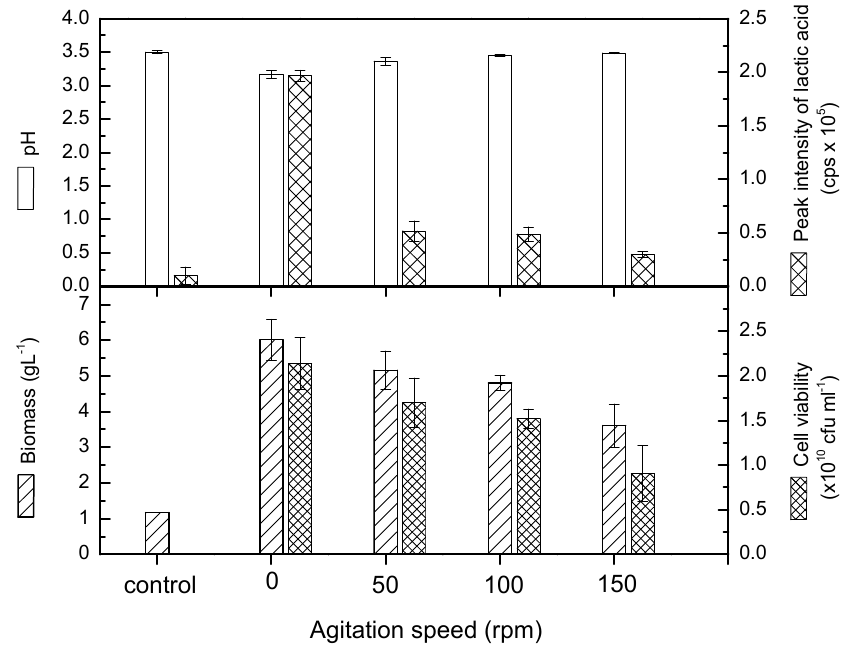
Figure 1. Cell viability, pH, and lactic acid content of probioticated pomegranate juice with L. casei at di ff erent agitation speeds. Means that do not share similar letters are significantly di ff erent.